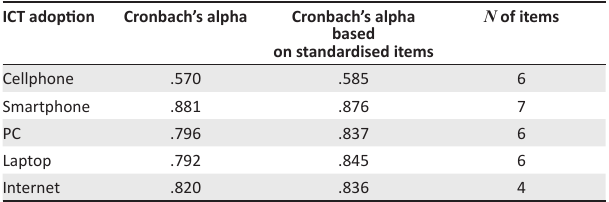
TABLE 3: Cronbach’s alpha reliability